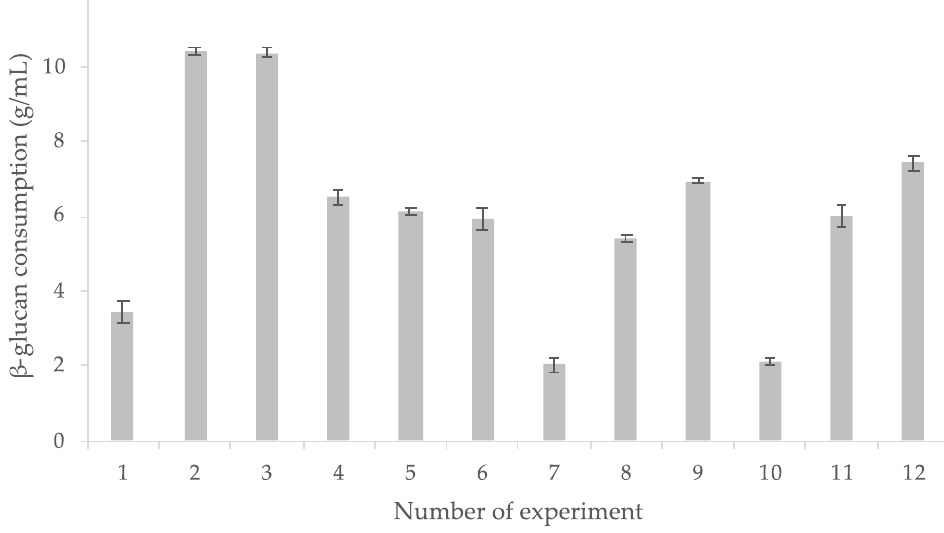
Figure 2. β -glucan consumption by L. rhamnosus GG under fermentation conditions according to the experimental design.